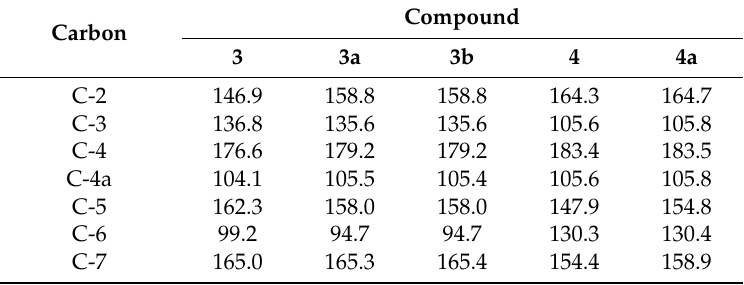
Table 4. 13 C-NMR shifts ( δ ) of quercetin ( 3 ) 1 and baicalein ( 4 ) 2 and products of their